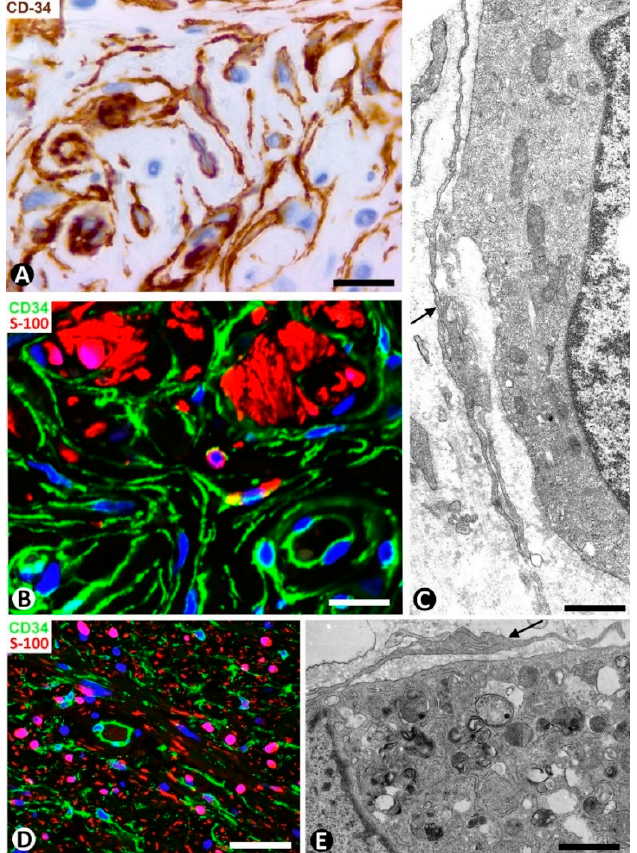
Figure 17. CD34+SCs/TCs in dermal melanocytic nevi ( A – C ), neurofibroma ( D ) and granular cell tumor ( E ). ( A ) Immunochemistry for CD34. Hematoxylin counterstain. ( B , D ) Double immunofluo- rescence for CD34 (green) and S100 protein (red). DAPI counterstain. ( C , E ) Ultrathin sections. Uranyl acetate and lead citrate. ( A , B ) CD34+SCs/TCs (brown in ( A ), green in ( B ) around nevic cells (red in B). ( C ) Ultrastructural image of long, thin telopodes (arrow) around a nevic cell. ( D ): Presence of CD34+ stromal cells (green) and Schwann cells (red) in a neurofibroma. ( E ) Ultrastructural image of a telocyte process (arrow) around a granular cell in a granular cell tumor. Bar: ( A , B ) 25 µm, ( C , E ) 4 µm, ( D ) 45 µm.